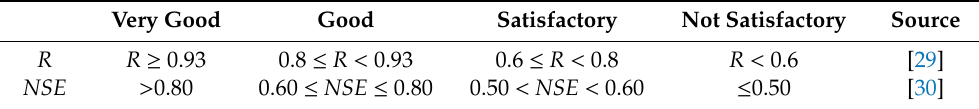
Table 3. Assessment of the evaluation criteria R and NSE .